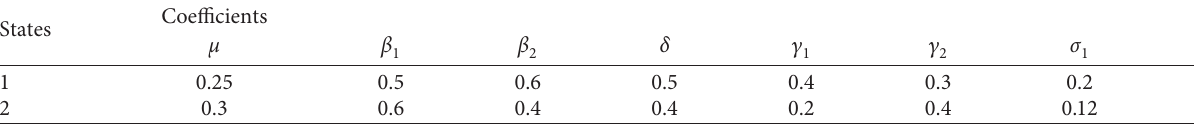
Table 1: Parameter values used in numerical simulations.